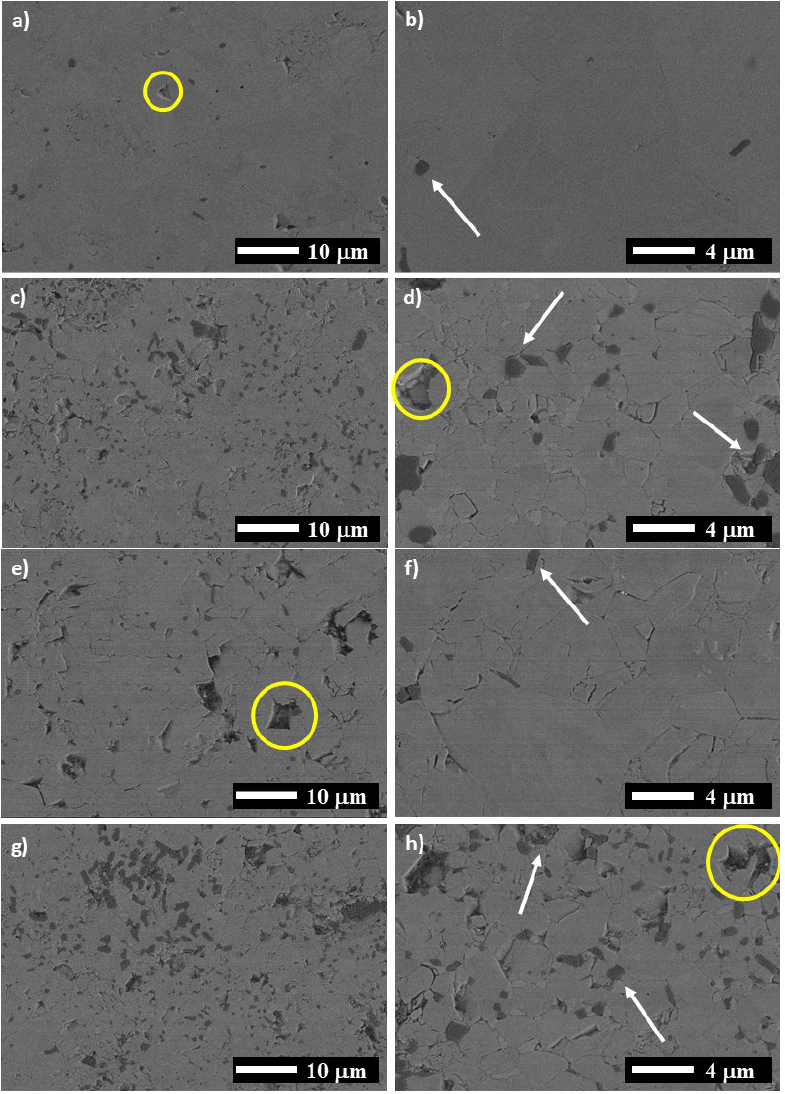
Figure 4. SEM images for: ( a , b ) MAX-1200, ( c , d ) MAX-1200M, ( e , f ) MAX-1200N and ( g , h ) MAX- 1200NM.